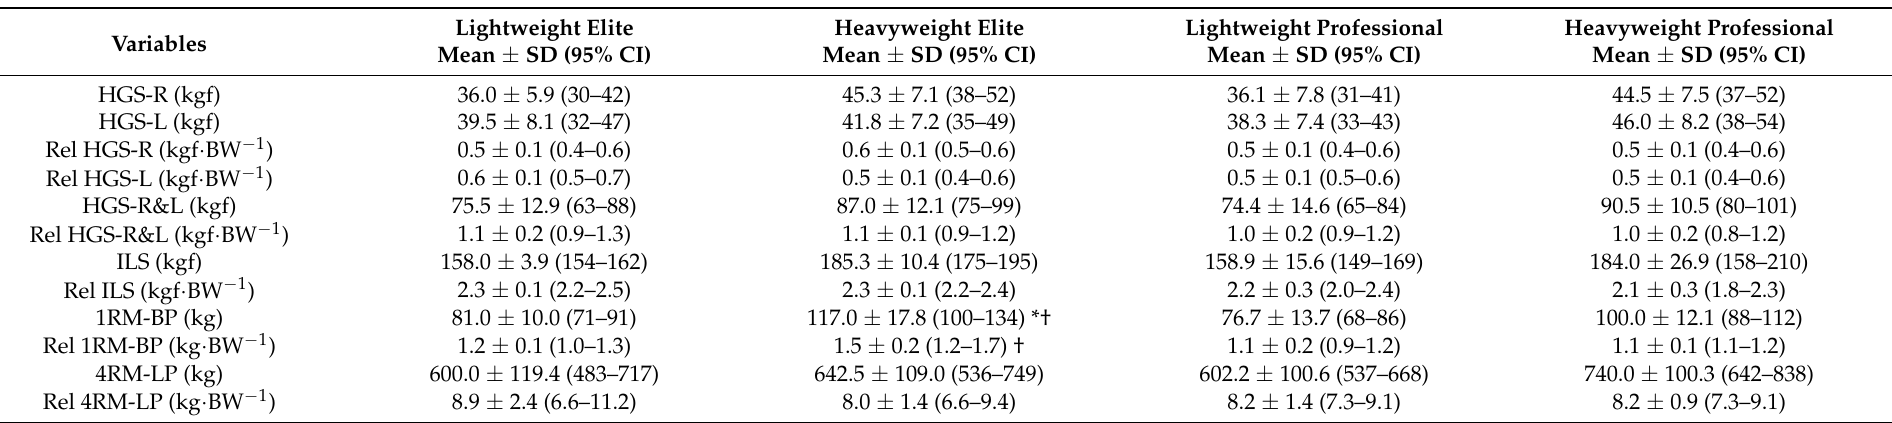
Table 2. Absolute and relative isometric and dynamic strength values according to the competitive level and weight